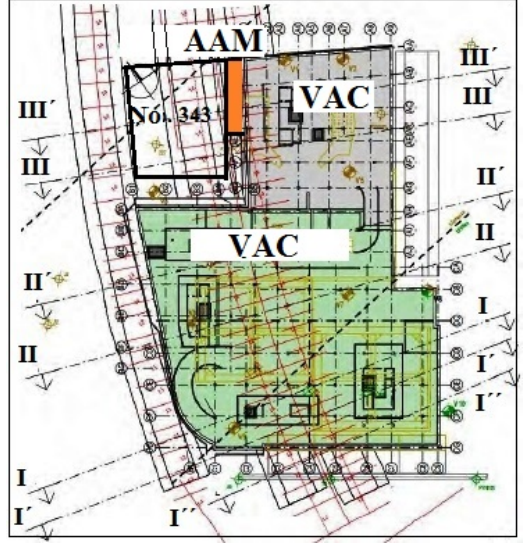
Figure 7. Cross-sections through the new VAC and AAM buildings ([2] – modified).